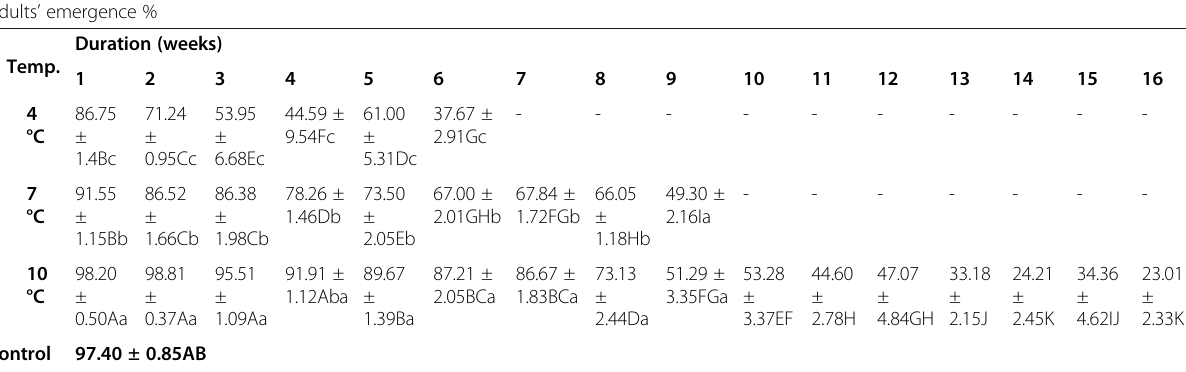
Table 2 Percentages of adults ’ emergences of Trichogrammatoidea bactrae in parental generation during storage of parasitoid larvae at different low temperatures Adults ’ emergence % Duration Temp.